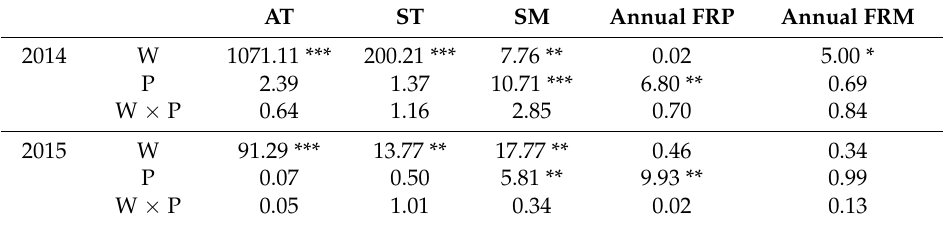
Table 1. F-ratios of two-way ANOVA on the effects of warming (W) and precipitation manipulation (P) on air temperature (AT), soil temperature (ST), soil moisture (SM), annual fine root length